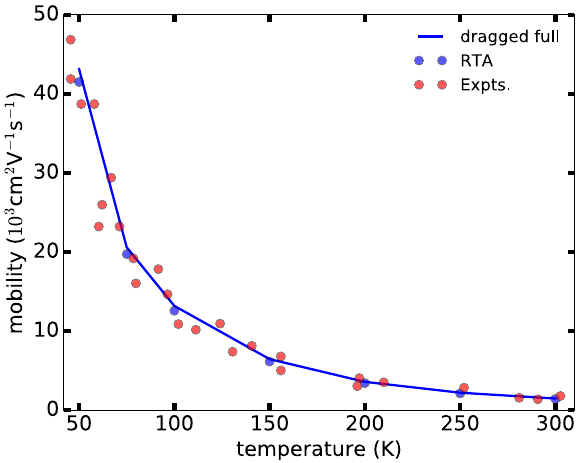
Fig. 4 Temperature dependence of the mobility of silicon for an n -type carrier concentration of 2.75 × 10 14 cm − 3 . The red circles are measurements on various different samples with carrier concentrations ranging from 3.5 × 10 13 to 1.4 × 10 14 cm − 352 .